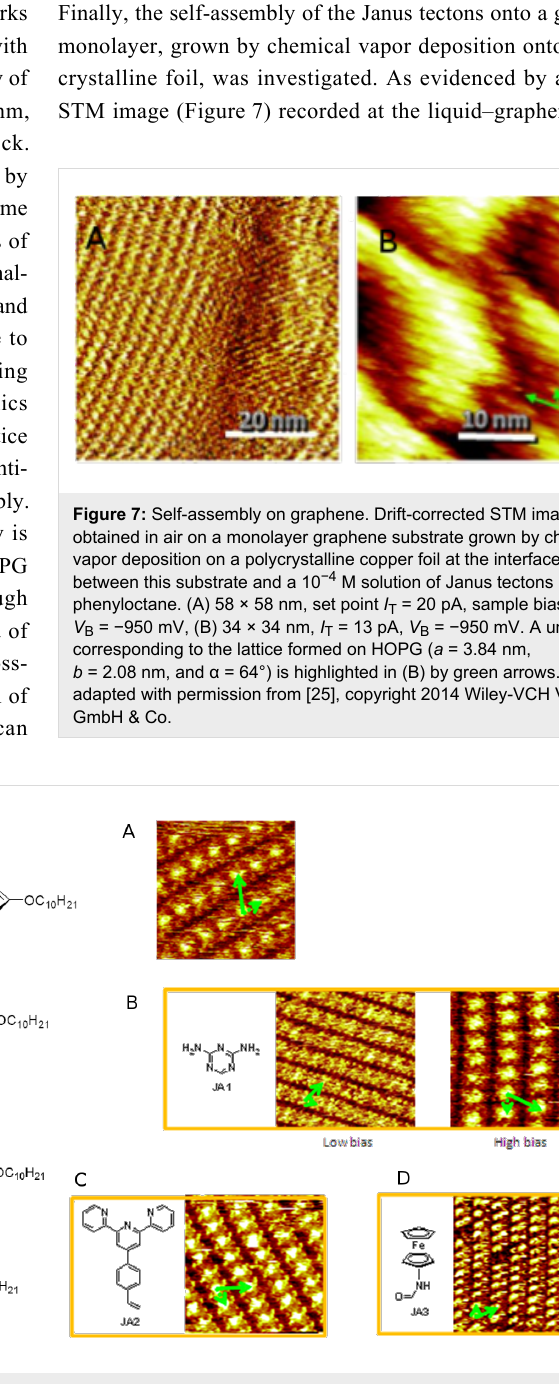
Figure 6: Self-assembly of a Janus tecton precursor (JAP) and the Janus tectons (JA). Drift-corrected STM images obtained at the interface between HOPG and a 10 − 4 M solution in phenyloctane of (A) JAP, 13 × 13 nm, set point I T = 35 pA, sample bias V B = − 1200 mV, (B) JA functionalized with triazine-4,5-diamine, low bias: 22 × 22 nm, I T = 8 pA, V B = − 950 mV and high bias: 15 × 15 nm, I T = 14 pA, V B = − 1350 mV, (C) JA functionalized with terpyridine, 16 × 16 nm, I T = 25 pA, V B = − 1500 mV, and (D) JA functionalized with ferrocene, 25 × 25 nm, I T = 20 pA, V B = − 1330 mV. One of the unit cells corresponding to the lattice formed by the non-functionalized pedestal, a = 3.84 nm, b = 2.08 nm and α = 64°, is highlighted in each image (green arrows) to illustrate the agreement between all Janus tecton lattices. Figure adapted with permission from [25], copyright 2014 Wiley-VCH Verlag GmbH & Co.